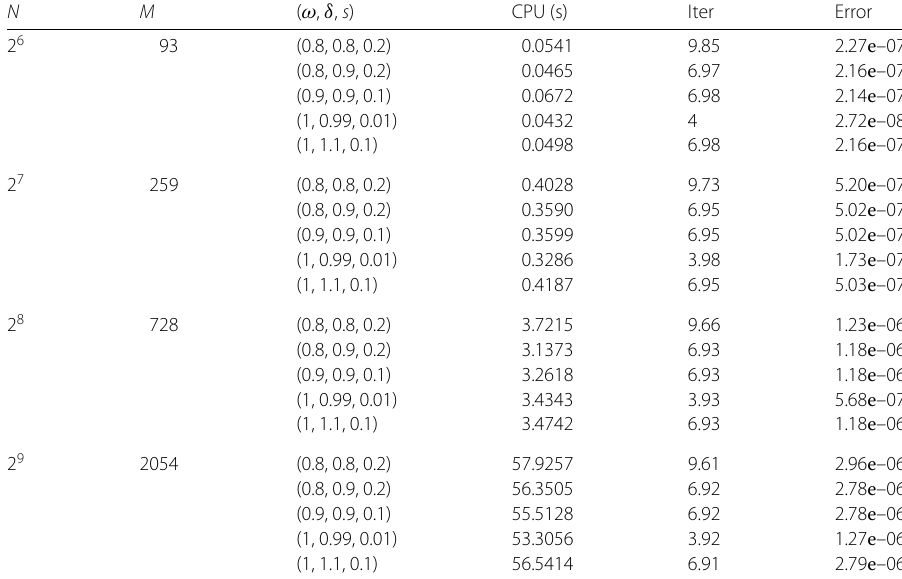
Table 1 The GPIU algorithm for solving Example 1 with different choices of parameters for α = 1.5